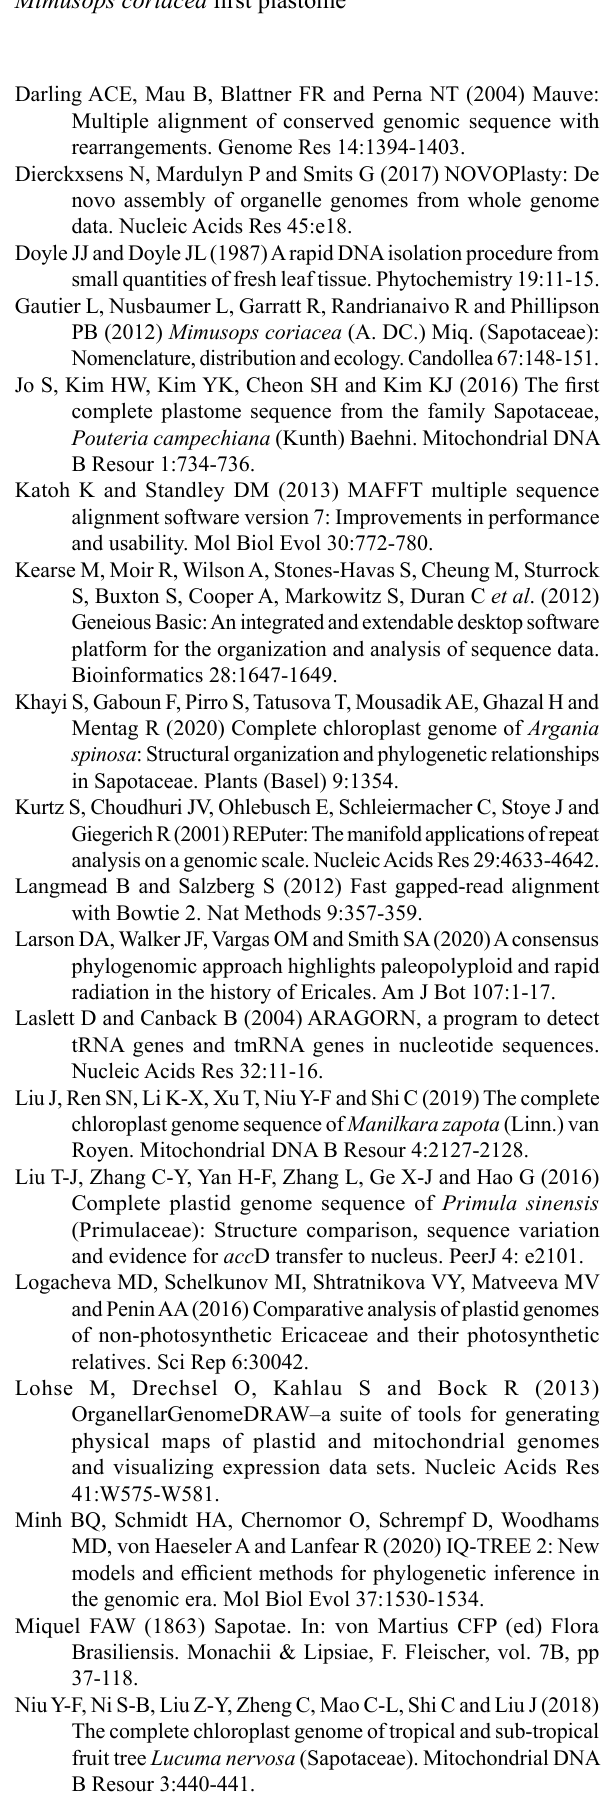
Figure S1 – Comparison of the IR and single-copy regions junctions from six Sapotaceae